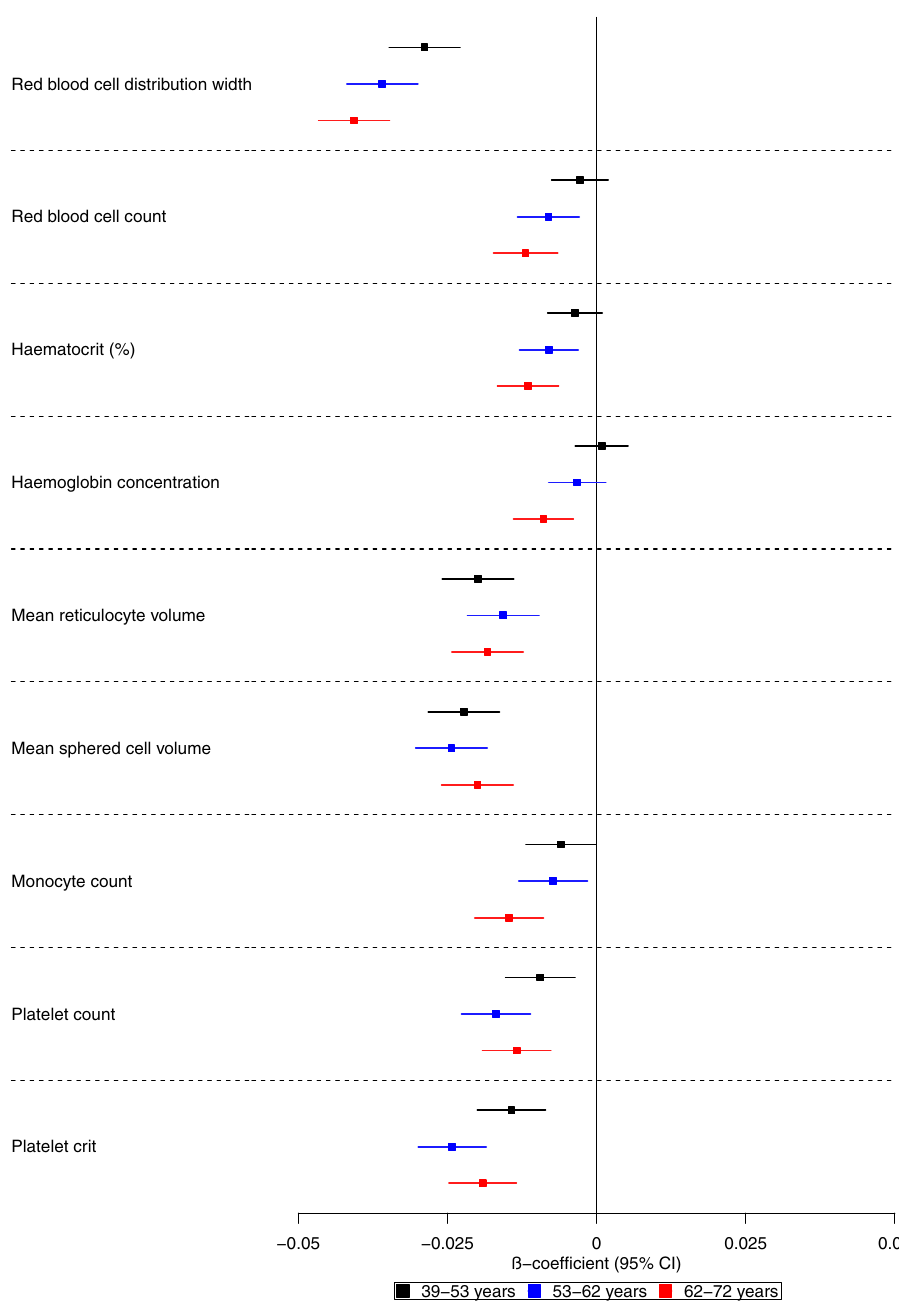
Fig.4|Forestplotshowingtheeffectestimatesfortheassociationbetweenthe polygenic score for Alzheimer ’ s disease (including the APOE region) and bio- logicalmeasures. Legendsonthe bottomofeachgraphindicate age tertiles. Each tertileconsistsof111,656participants,orderedbyage.Effectestimatesrepresentan SD change in the phenotype per 1 unit increase in the standardized polygenic risk